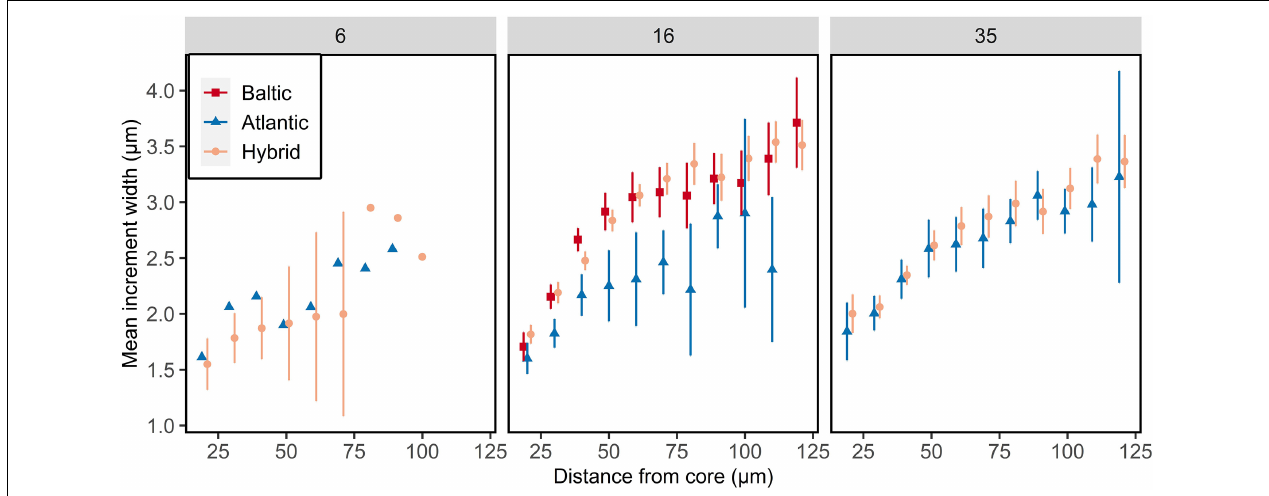
FIGURE 6 | Otolith growth of F1 larvae reared at salinity of 6, 16, or 35 psu. Mean increment width ± 95% confidence intervals are given for each 10 µ m interval. Data points are offset for visual clarity. Confidence intervals are only displayed for n >